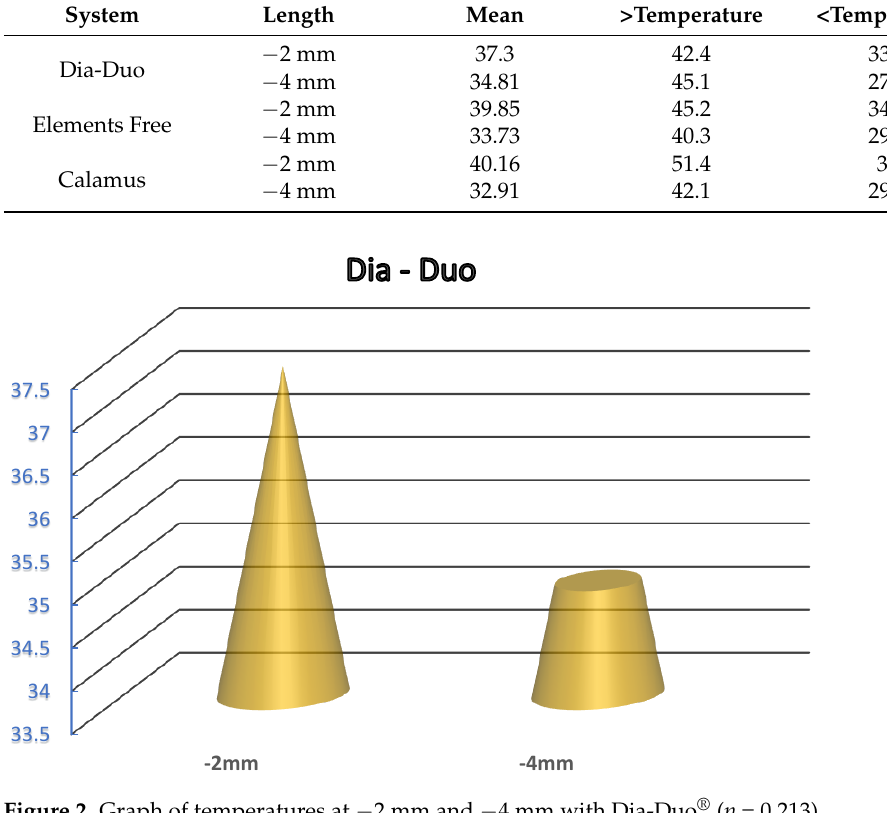
Figure 2. Graph of temperatures at − 2 mm and − 4 mm with Dia-Duo ® ( p = 0.213).